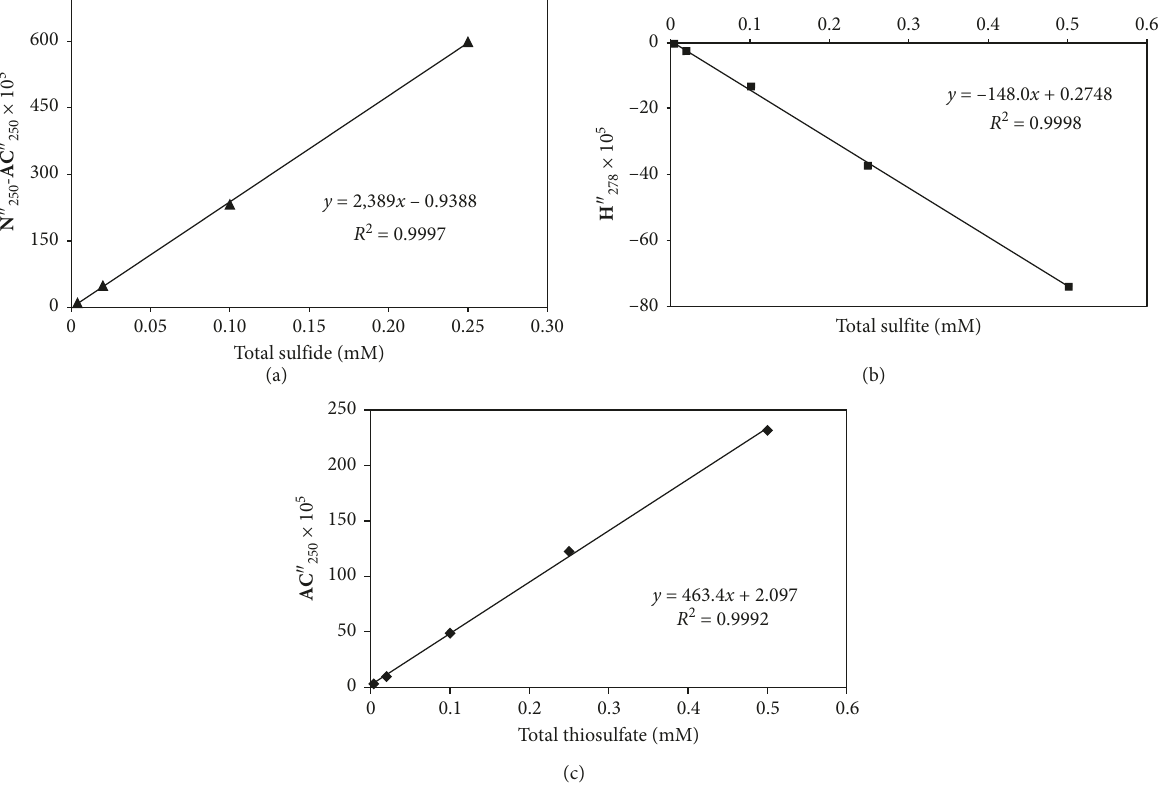
Figure 4: Calibration curves of the second-derivative absorbance parameters for total sulfide (a), total sulfite (b), and total thiosulfate (c) in water at 25 ° C.